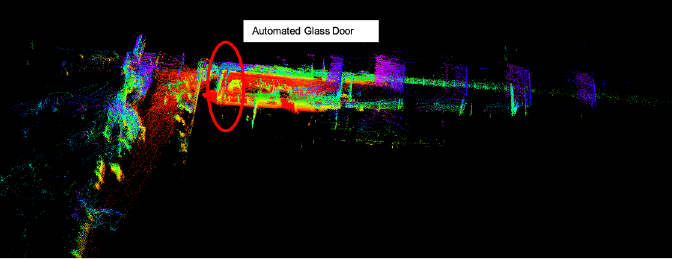
Figure 12. Mapping through an automated glass door.